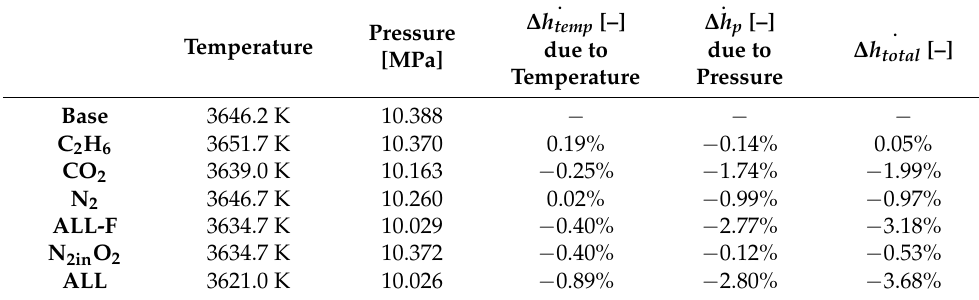
. . ∆ h ∆ h p [–] temp [–] . Pressure ∆ h total [–] due to due to [MPa] Pressure Temperature